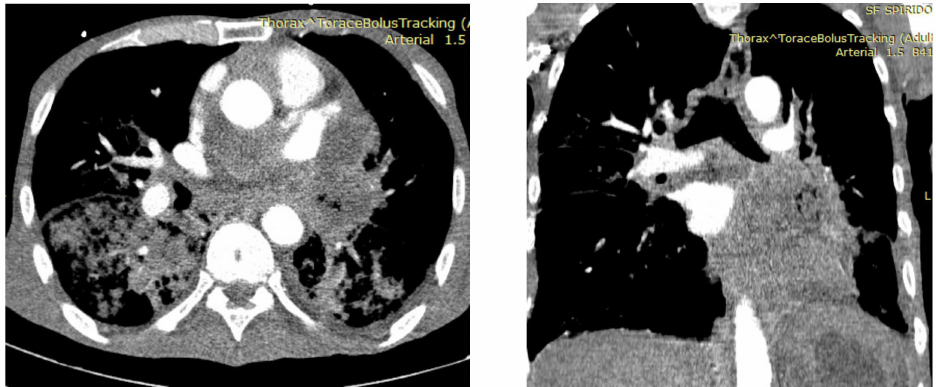
Figure 2. Tumoral infiltration of the mediastinum, with direct invasion and tumoral thrombosis of the left pulmonary artery and its lobar branches; partial tumoral thrombosis of the segmentary